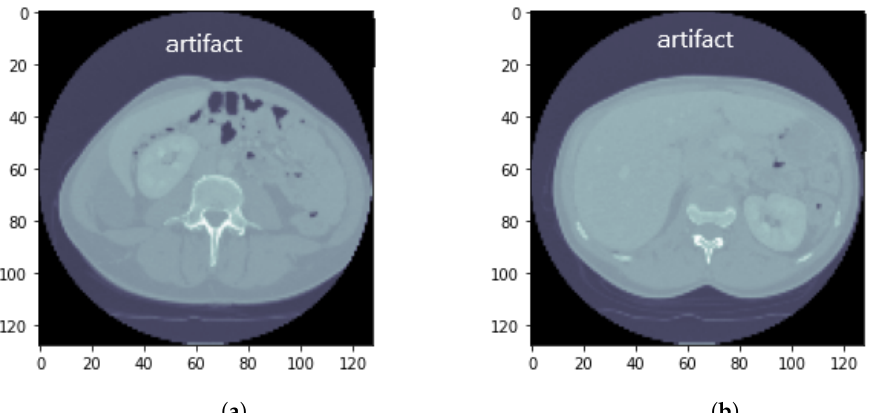
Figure 5. Two different samples of altered CT-Scans from the 3Dircadb1 dataset: presence of an additional grey circular area that encloses the body section, marked by the word ‘artifact’ to better highlight